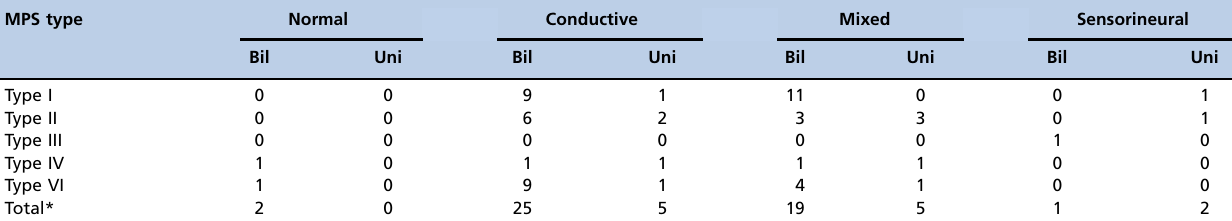
Table 2 - Results of the audiometric evaluation per type of MPS